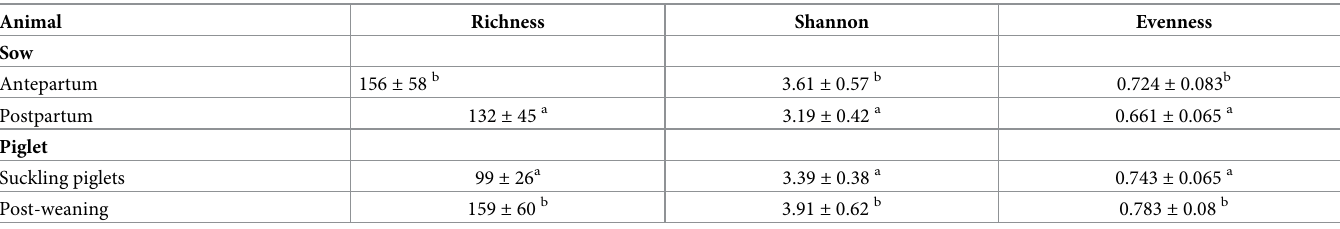
Table 2. Diversity indices of the microbiota in sows and piglets at different time points.